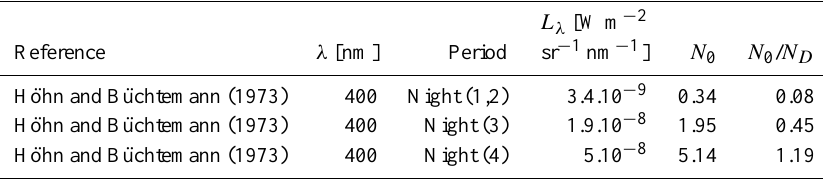
Table 3. Sky Spectral Radiance for different weather conditions and corresponding sky background for the H 2 O channel future lidar system (integration time of 30min is